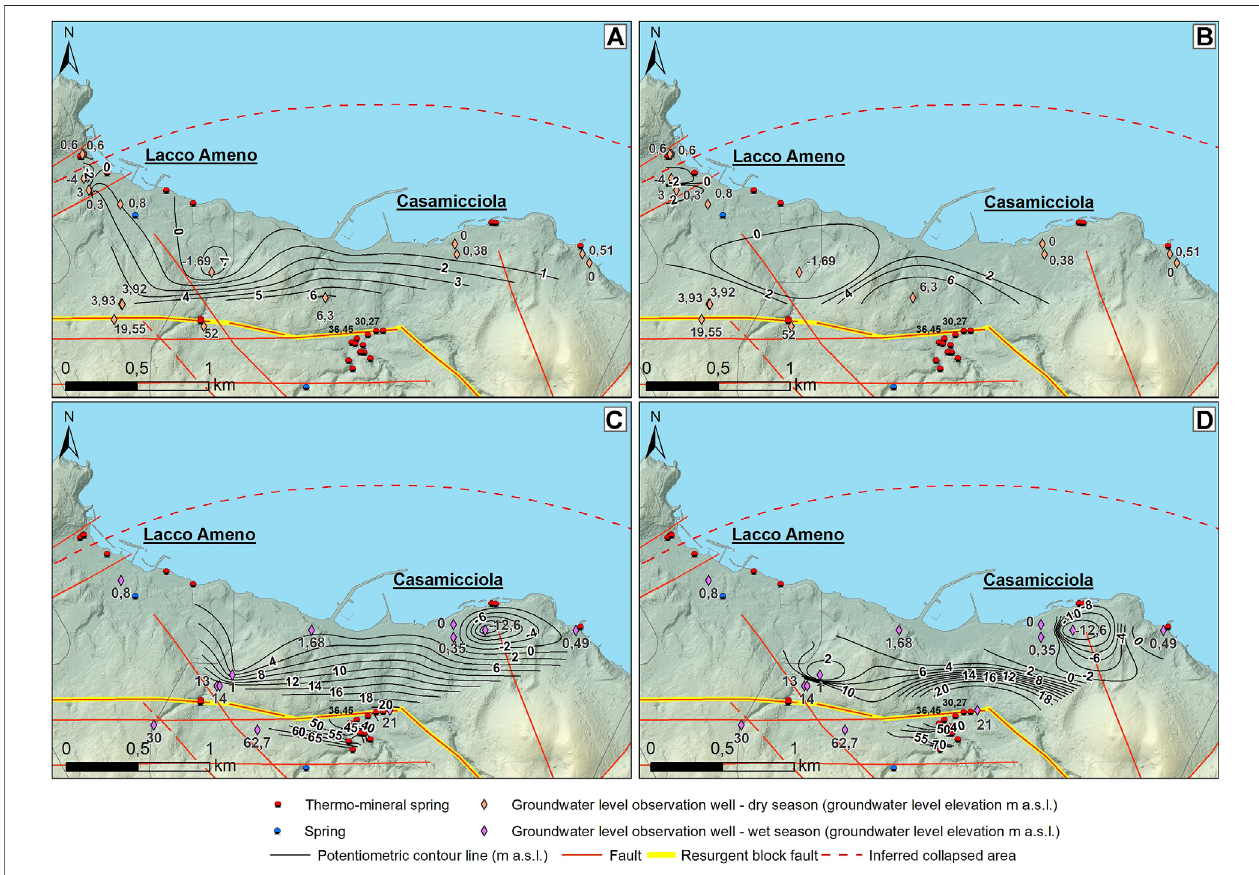
FIGURE 6 | Piezometric surface map of the Casamicciola – Lacco Ameno sector: (A) NaN interpolation (dry season); (B) IDW interpolation (dry season); (C) NaN interpolation (wet season); (D) IDW interpolation (wet season). DEM details are in Figure 2 .